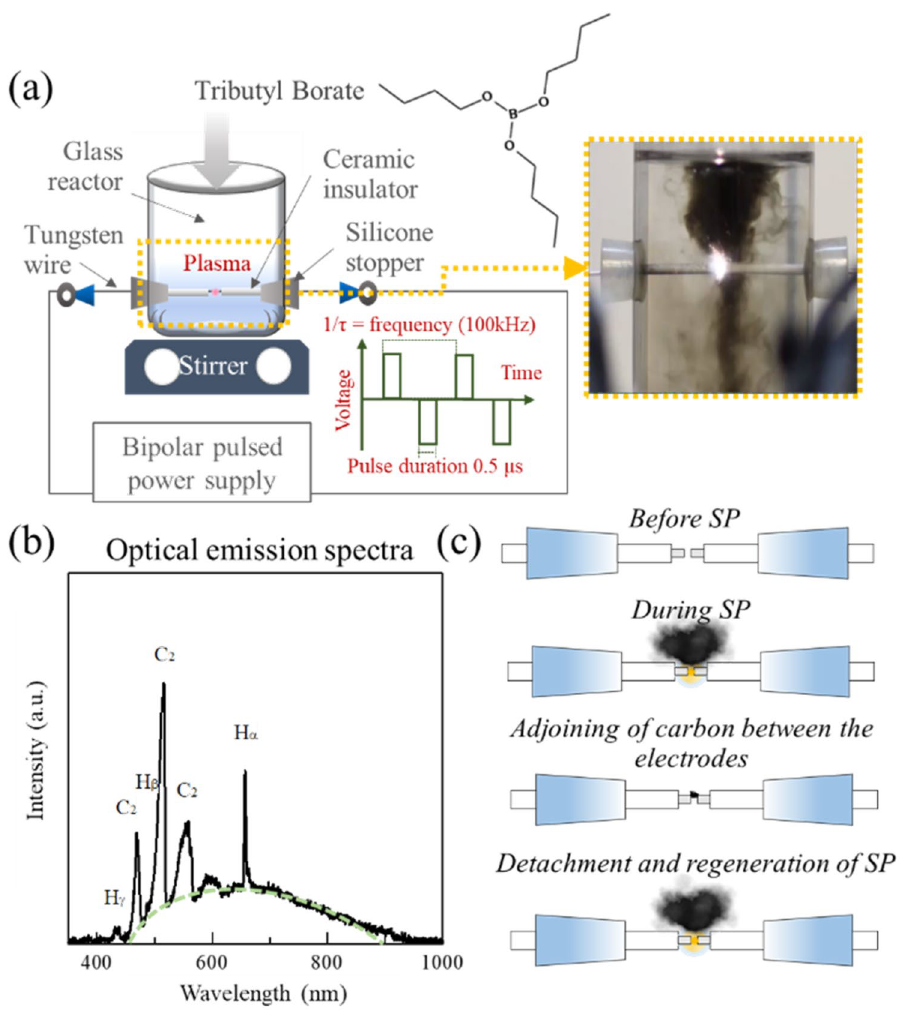
Figure 1. Illustration of ( a ) SP set up in this study with actual images of synthesis of carbon samples via SP, ( b ) OES measurement, and ( c ) possible formation of carbon